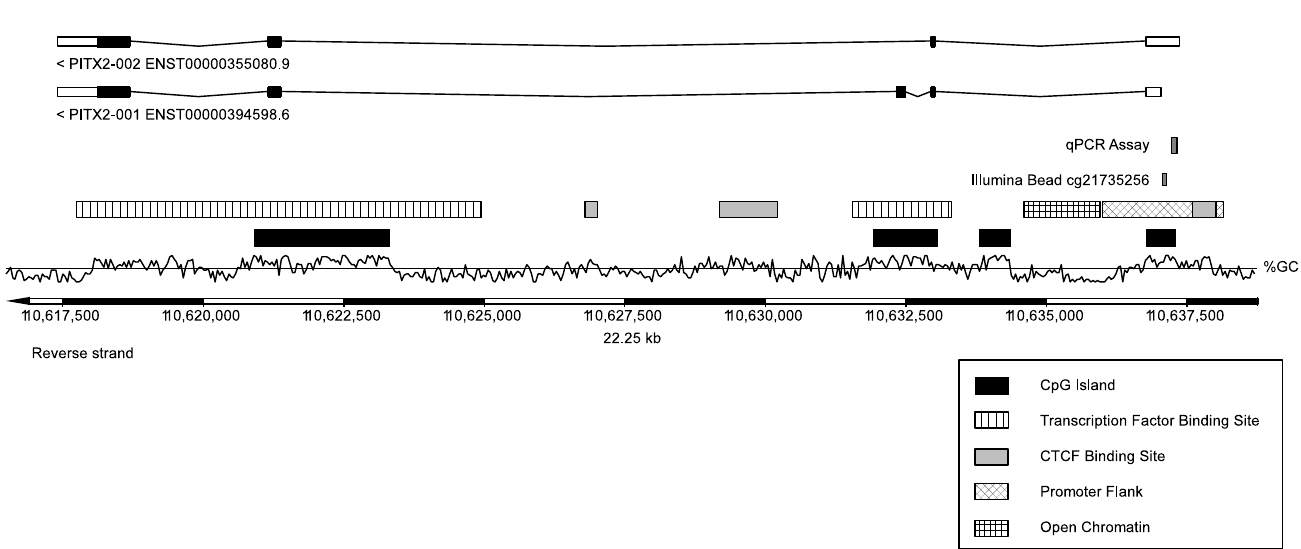
Fig 1. Organization of the PITX2 gene. Genomic organizationof the PITX2 gene and locationsof the PITX2 qPCR assay [16] and the Illumina HumanMethylation450 BeadChip bead cg21735256.The information was taken from Ensembl Homo sapiens versionGRCh38.p7.